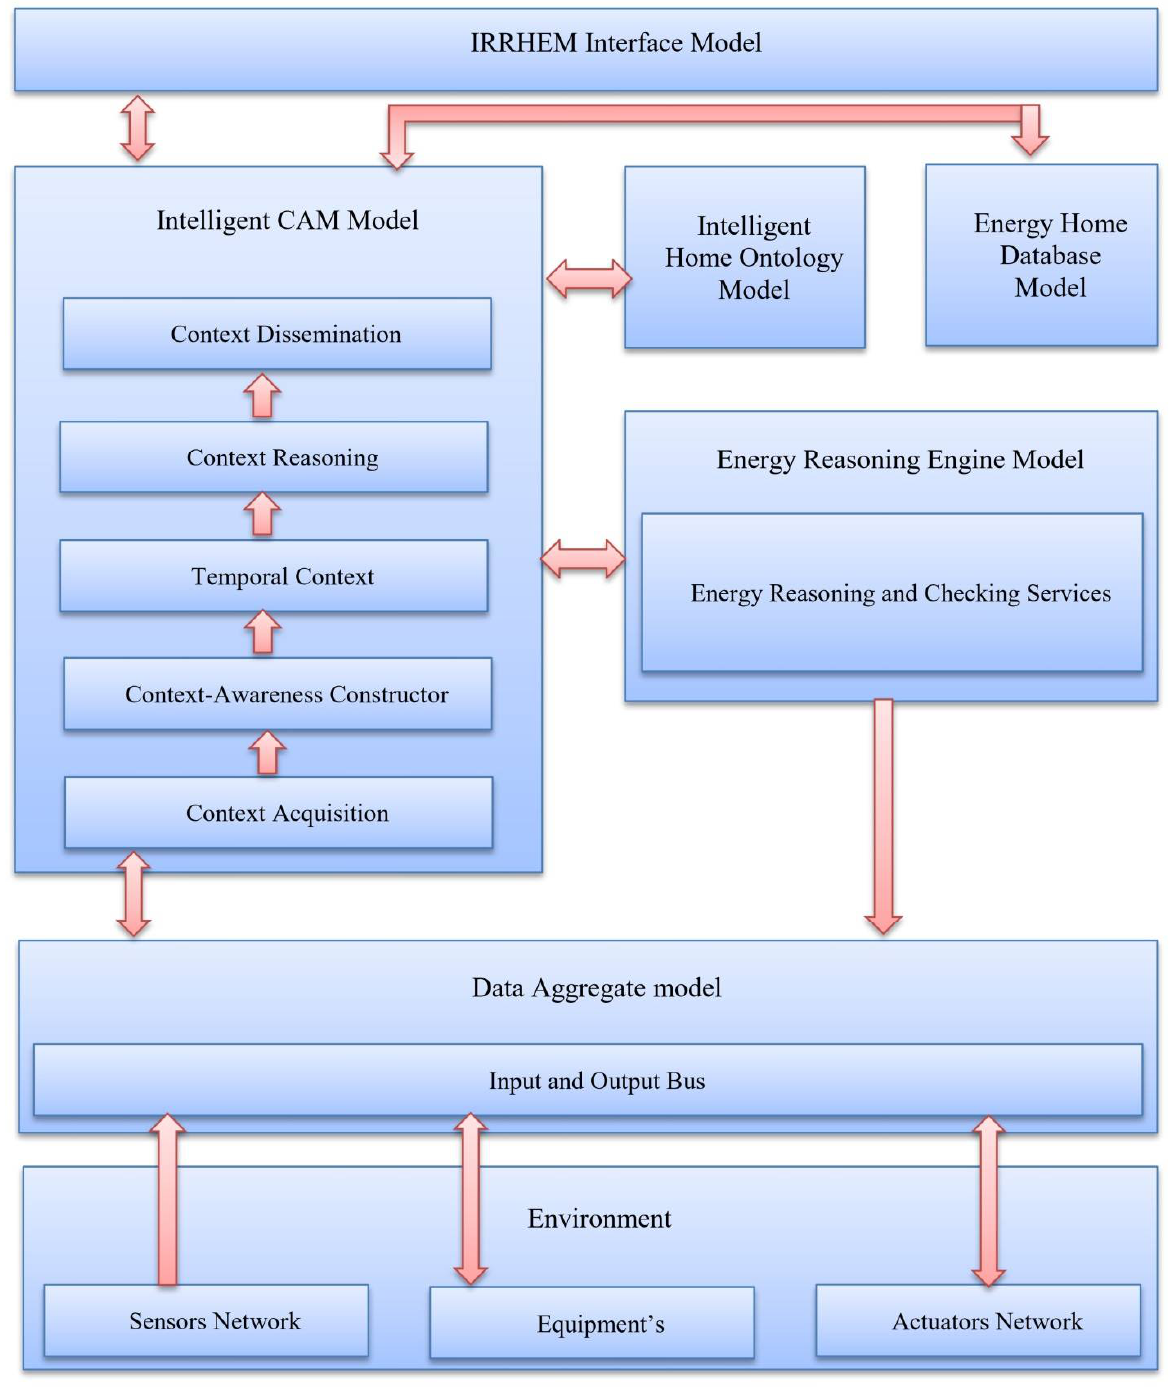
Figure 2. Architecture of IRRHEM.